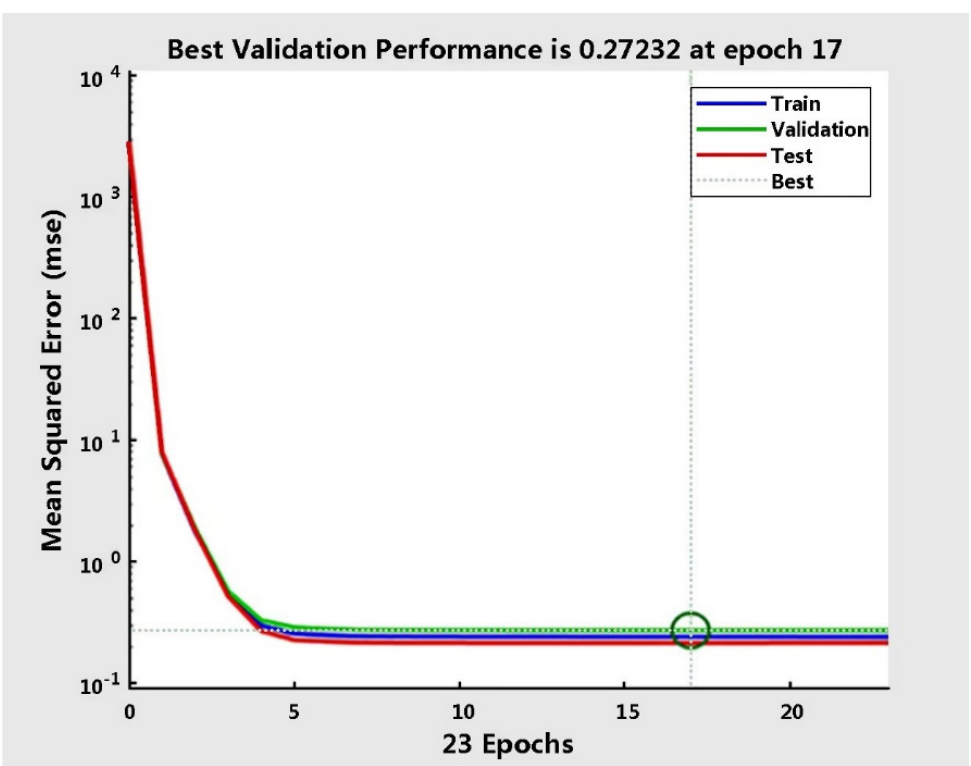
Figure 1. Performance of neural network at Epoch 17.